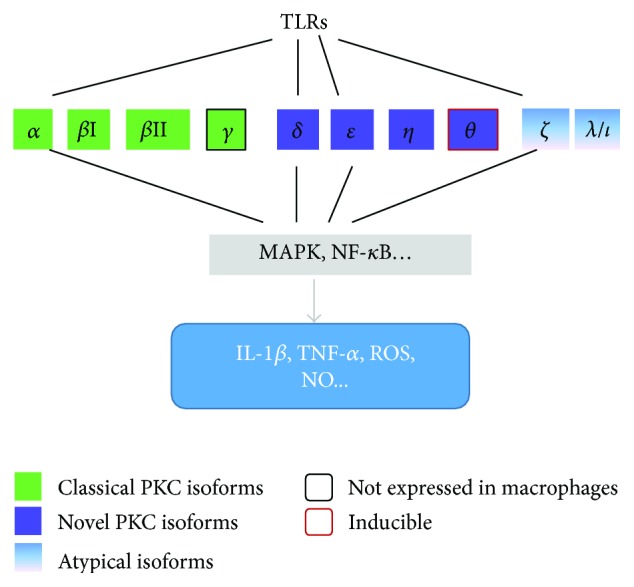
The expression of PKC isoforms in macrophages and their role in TLR-mediated inflammatory response. Among them eight, PKC isoforms (PKCα, βI, βII, δ, ε, η, ζ, and λ) are expressed in macrophages. PKCα, δ, ε, and ζ are directly related to TLR-induced inflammatory response. PKCθ expression in macrophages cannot be detected, but its expression can be induced by LPS/IFNγ stimulation.